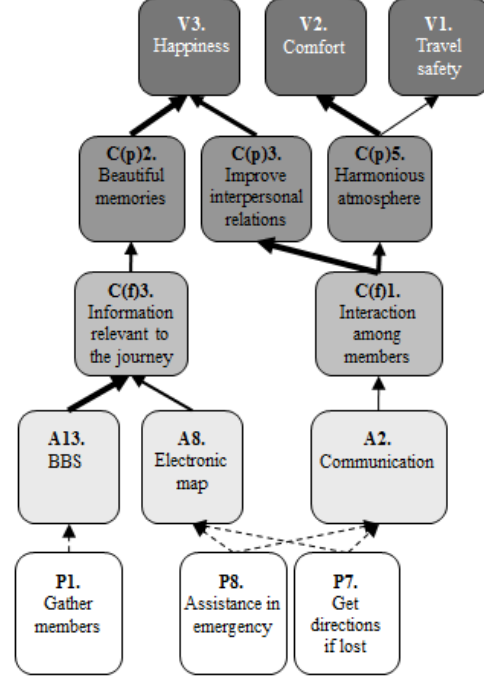
Figure 6. Streamlined Hierarchical Value